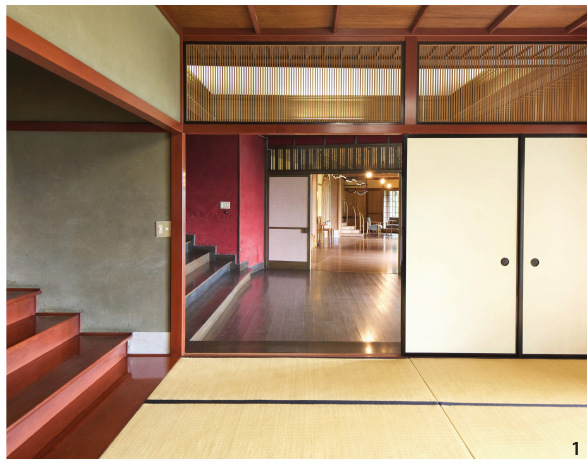
Figure 1 Hyuga Villa (Source: Dave